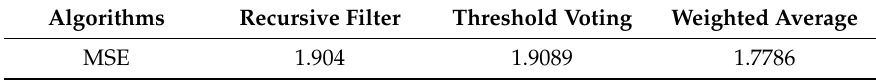
Table 11. Mean squared error